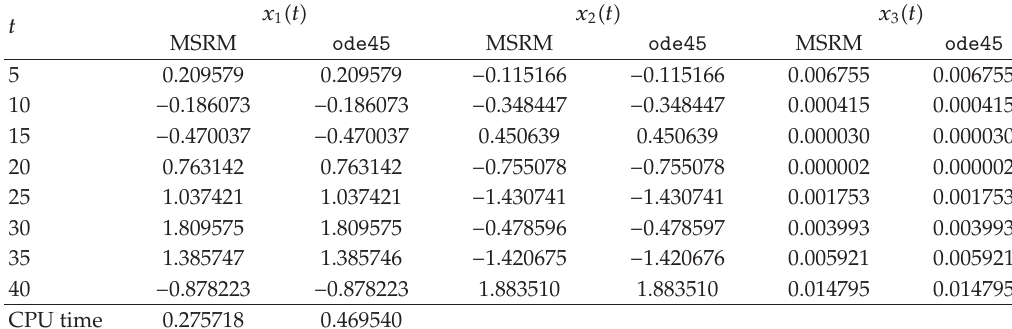
Table 6: Comparison of the numerical solution of Rabinovich-Fabrikant equations obtained by the MSRM and ode45 for a (cid:9) 0 . 1 and b (cid:9) 0 .